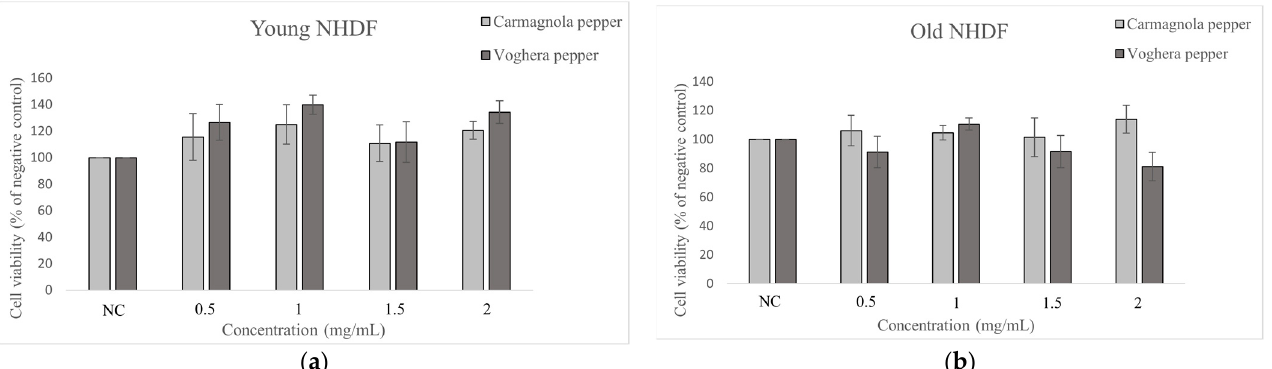
Figure 2. Cell viability after 24 h-exposure to different concentrations of two different pepper extracts, i.e., VP or CP: ( a ) Young NHDF; ( b ) Old NHDF. Values are mean ± SEM; Anova one-way test: not statistically significant.